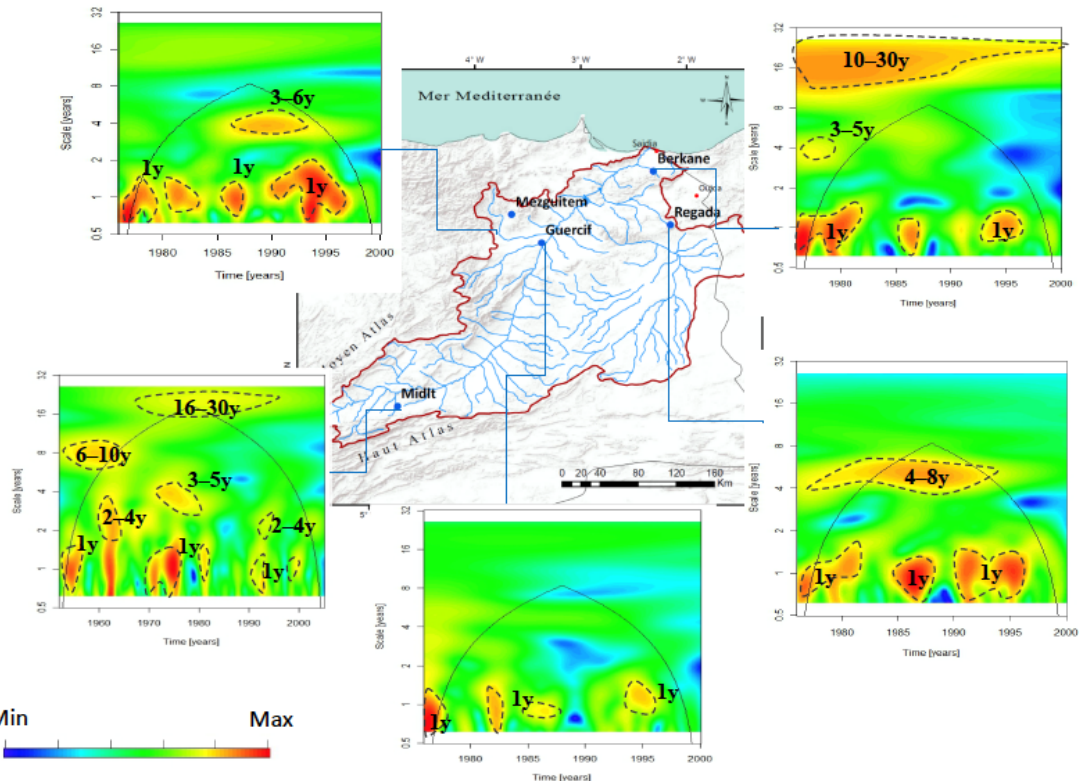
Figure 6. Spectra of continuous wavelet analysis of rainfall in the Moulouya basin.